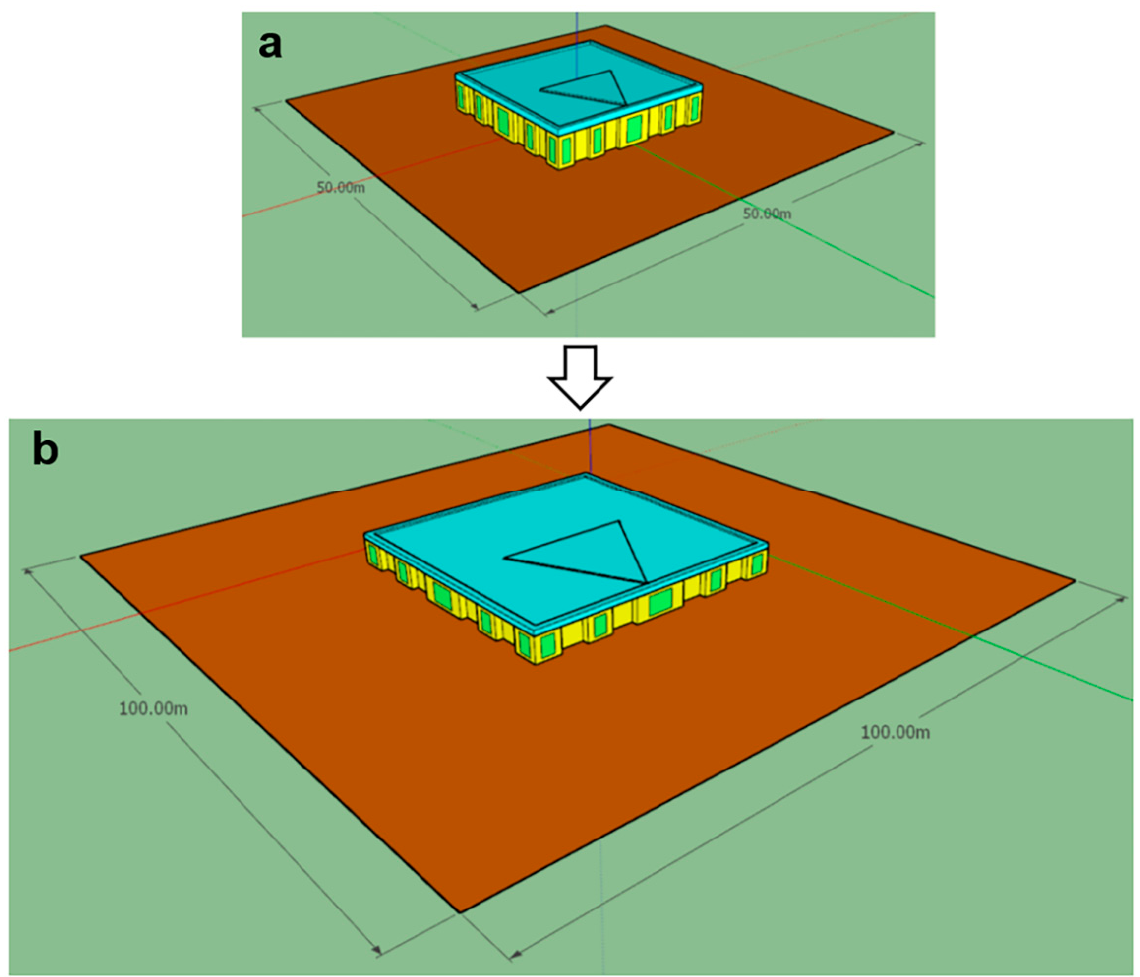
Figure 8. Two variants of model: ( a ) initial and ( b ) scaled.